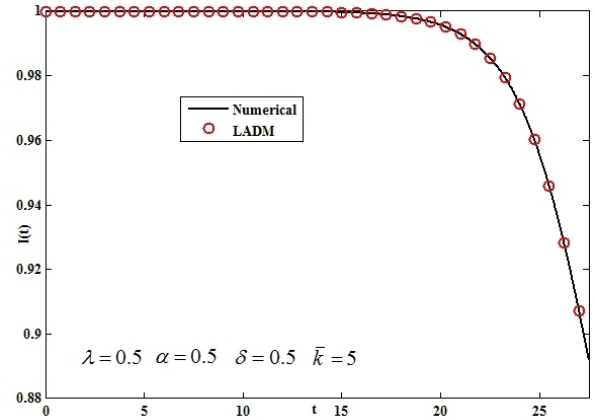
Fig. 5. Comparison of the LADM solutions of I(t) with numerical method.